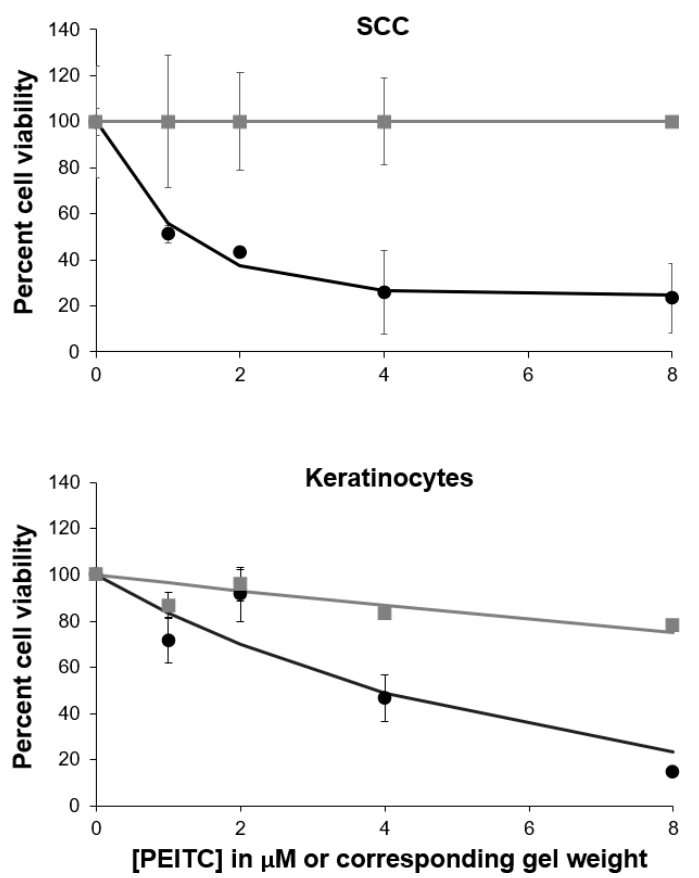
Figure 4. Dose-responses with the treatment of phenethyl isothiocyanate (PEITC) carbomer gel at concentrations of 1, 2, 4, and 8 µM PEITC and blank carbomer gel at corresponding masses. Blank carbomer gel toxicities are shown with gray square markers and the gray line, and PEITC carbomer gel toxicities are shown with black circle markers and the black line.